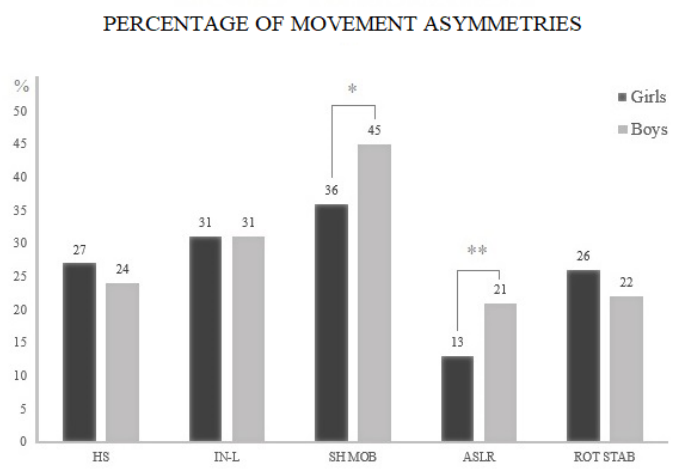
Figure 3. Proportion (%) of adolescent girls and boys who demonstrated movement asymmetries